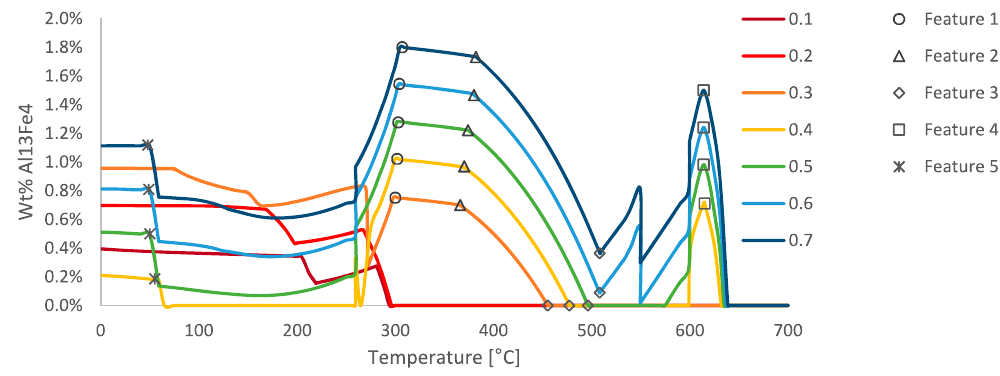
Figure 27. Effect of varying the content of iron on the equilibrium Al 13 Fe 4 phase amount. The features are identified in the equilibrium isopleth in the following figure. Materials 2020 , 13 , x FOR PEER REVIEW